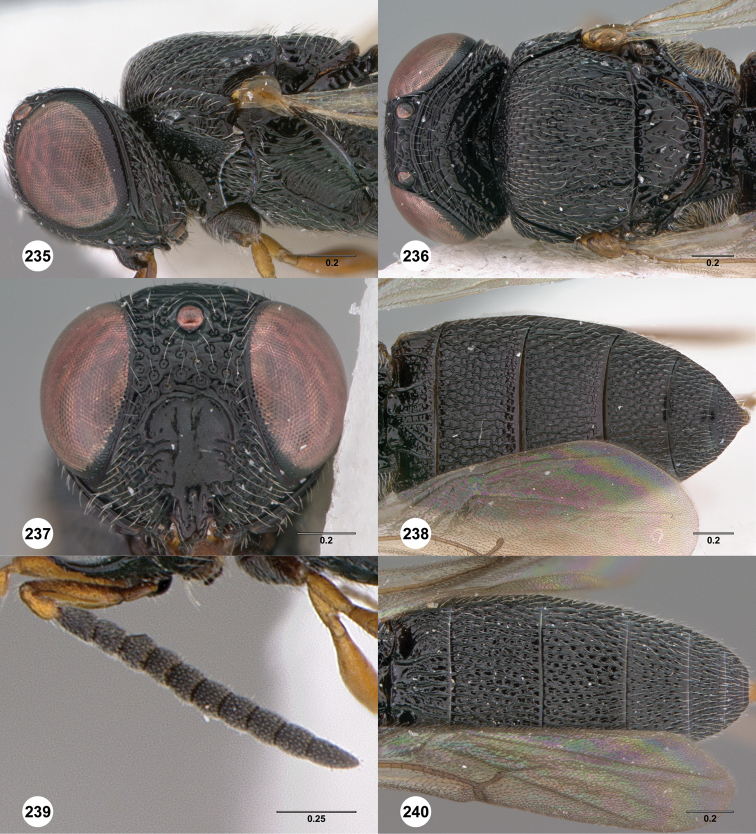
Oxyscelio obturationis sp. n., holotype female (OSUC 439017) 235 Head and mesosoma, lateral view 236 Head and mesosoma, dorsal view 237 Head, anterior view 238 Metasoma, dorsal view. Paratype male (OSUC 442295) 239 Antenna 240 Metasoma, dorsal view. Morphbank73